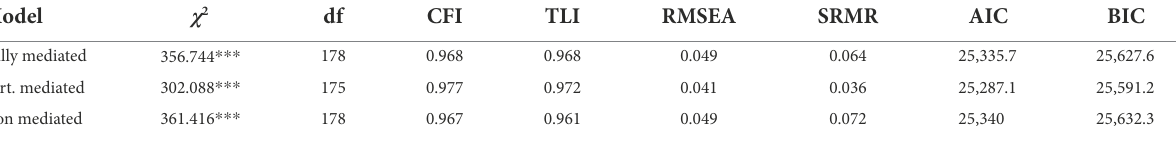
TABLE 2 Fit indices for the three models.